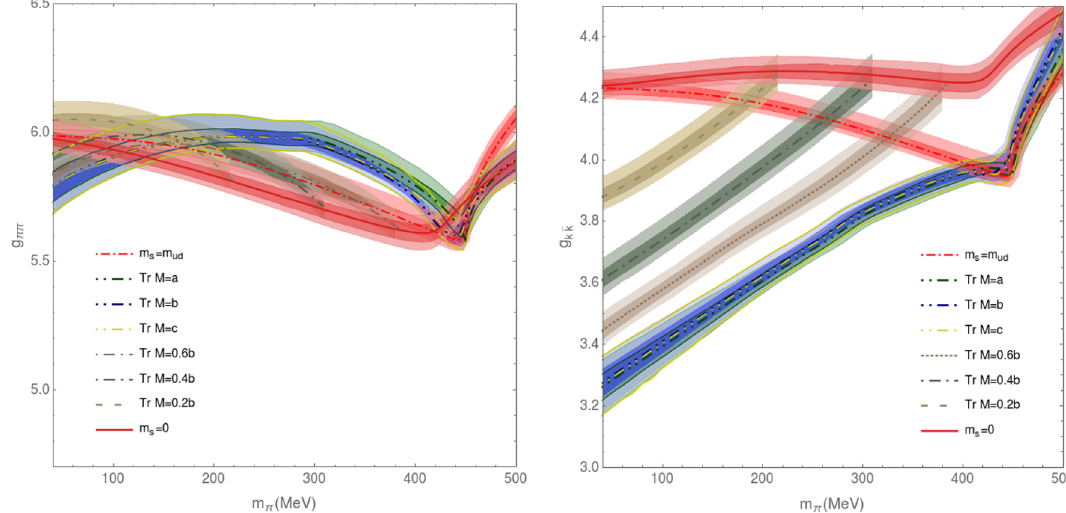
Figure 35 . The couplings of the (cid:26) -meson pole to the (cid:25)(cid:25) and K (cid:22) K channels, g (cid:25)(cid:25) and g Tr M = C trajectories in comparison with the m s = 0 and m s = m u ones.